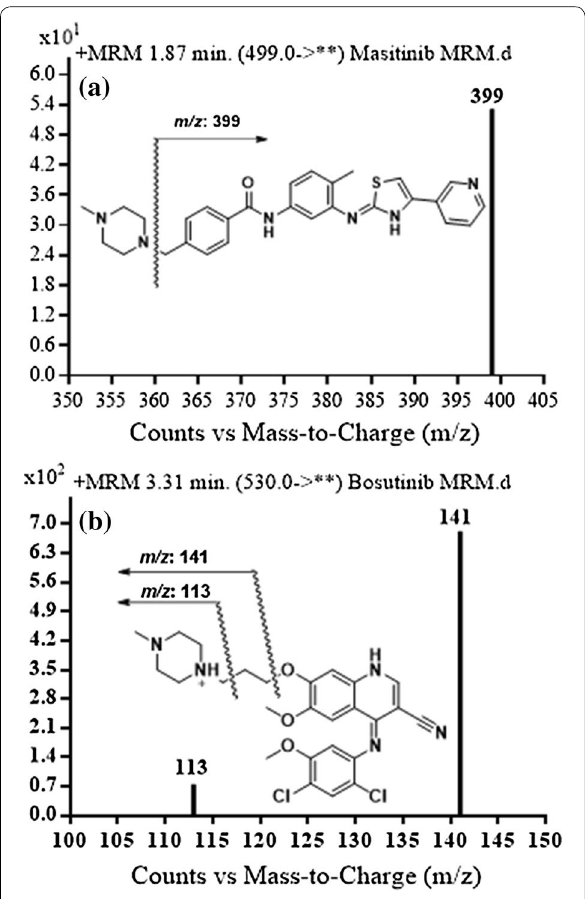
Fig. 3 MRM mass spectra of a MST and b Bosutinib